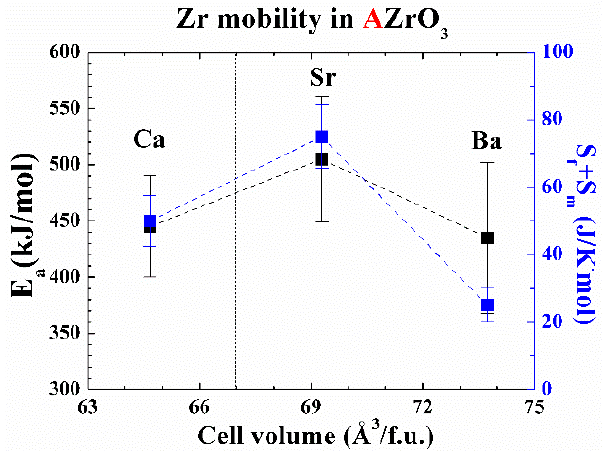
Figure 4. The dependence of the activation energy for 96 Zr lattice diffusion in AZrO 3 perovskites and corresponding activation entropy of formation and migration on the unit cell volume per formula unit